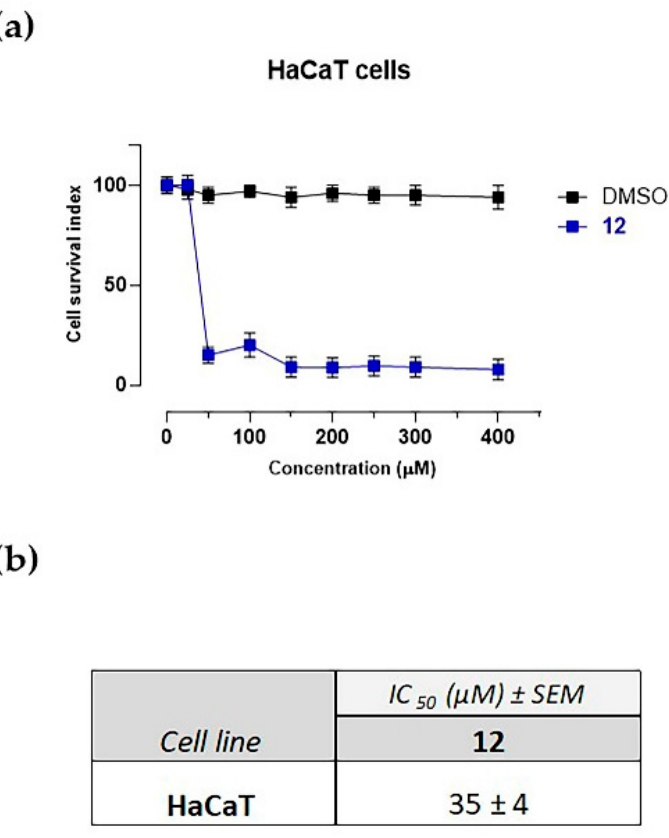
Figure 5. ( a ) Cell survival index, evaluated by the MTT assay and monitoring of live/dead cell ratio relative for the compound 12 for the HaCaT cell line following 48 h of incubation with the indicated concentration (the range 1 → 400 µ M), as indicated in the legend. Data are expressed as percentage of untreated control cells and are reported as mean of five independent experiments ± SEM (n = 30); ( b ) IC 50 values ( µ M), relative to the compound 12 for the HaCaT cell line following 48 h of incubation. The IC 50 values are reported as mean values ± SEM (n = 30). 3. Discussion The oxadiazoles are a class of five-membered heterocycles that are of considerable interest in organic and medicinal chemistry [20]. In some bioactive compounds, they act as bioisosteres of ester and amide, with improved pharmacokinetic and pharmacody- namic profiles and enhanced selectivity; in other cases, the rigid heterocyclic ring acts as a flat aromatic spacer, assuring the appropriate substituent geometry. A vast number of oxadiazole-containing scaffolds are found to possess diverse biological activities, such as anticancer, anti-inflammatory, antiallergic, anticonvulsant, antiviral, antibacterial, anti- Alzheimer activities, as well as specific inhibitor properties against enzymes [21,22]. This study aims to further explore the chemical space around the oxadiazole ring. In particular, we have focused our attention on 1,2,4-oxadiazole-containing derivatives in order to find easily accessible chemical entities active against clinically relevant bacterial strains. Starting from the lead compound 1 , obtained by Chang and coworkers after an ex- tensive SAR investigation of oxadiazole derivatives [11], and taking into account the promising MIC of the related structure 3 , in the present study, we fixed the 4-indolyl sys- tem as ring A, and we varied the size and the functionalization of the aromatic right por- tion at the C-3 position of the oxadiazole ring. The SAR was established by an initial screening of the synthetic derivatives against two MSRA S. aureus strains. Among the fif- teen synthesized compounds, two ( 3 and 12 ) displayed the best activity, and 12 was se- lected as the most promising for its ability to contrast the growth of S. aureus and the MRSA strain at an MIC value of 2 µM. The MIC values reported were indicative of the marked influence of the substituents at C-3 of the oxadiazole ring on the antimicrobial activity. In particular, the most active compounds, 3 and 12 , featured, respectively, 4-(3-thienyl)phenyl and 1,1 ′ -biphenyl-4-yl substituents, namely, a para -biaryl unsubstituted system. No activity was observed for compound 4, with ring C meta -substituted with 3-thienyl ring. Moreover, the weaker ac- tivity of compound 3 (MIC 4 µM), as compared to compound 12 (MIC 2 µM), could be ascribed to the lesser degree of aromaticity of the heterocyclic thiophene in compound 3 vs. the phenyl moiety in compound 12 .